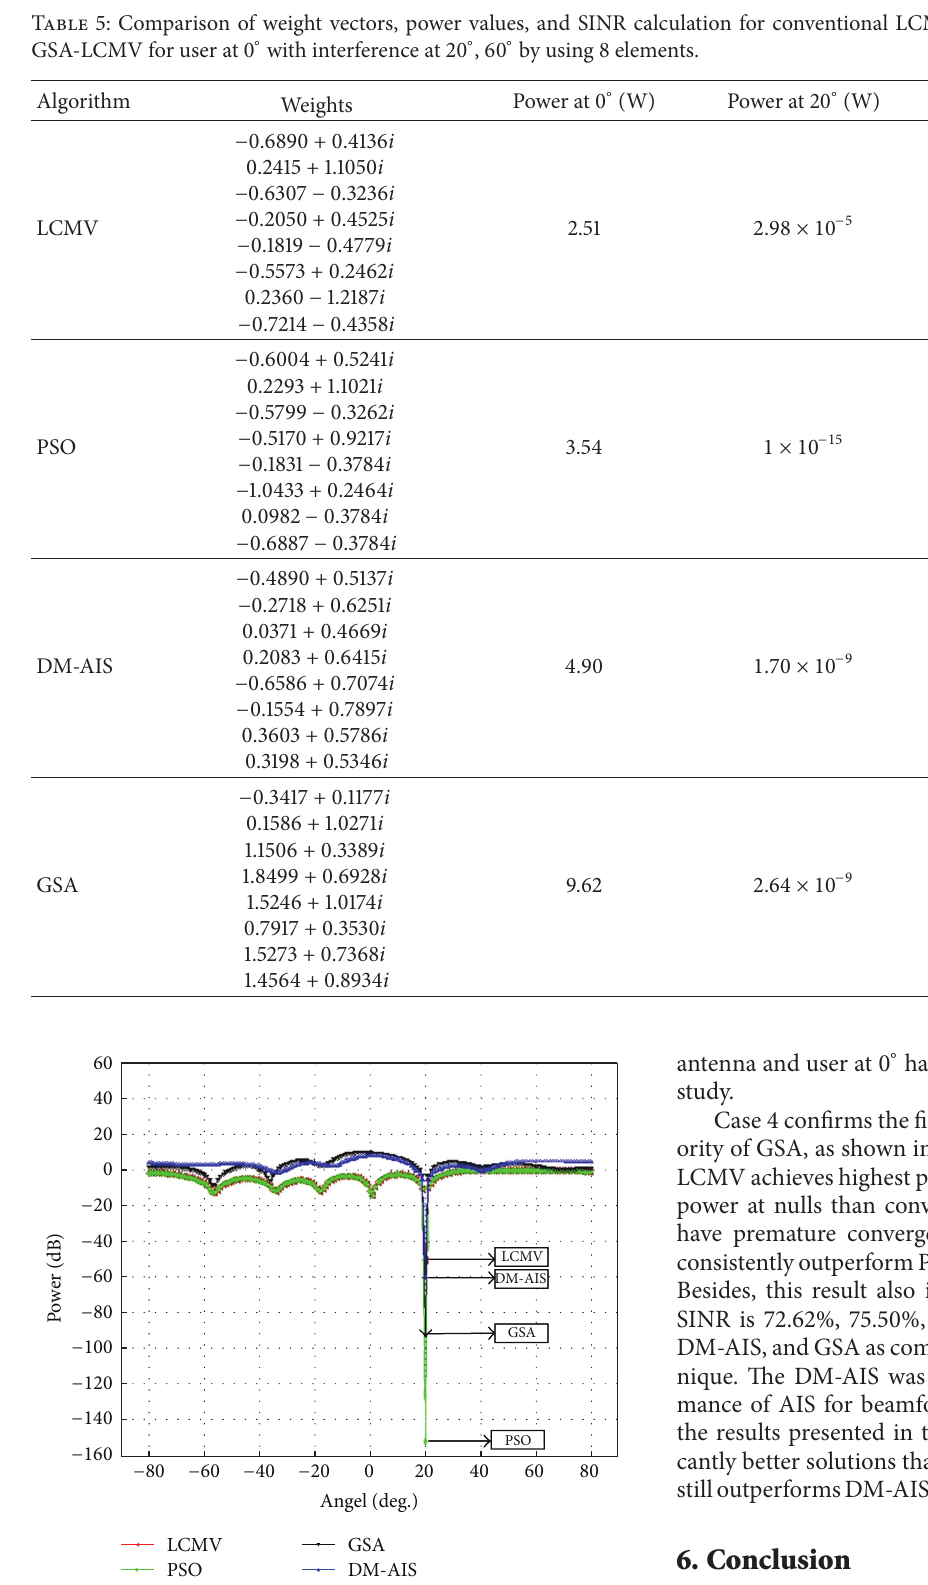
Figure 3: Comparison of performance of power response LCMV, PSO-LCMV, DM-AIS-LCMV, and GSA- LCMV for user at 0 ∘ with interference at 20 ∘ by using 8